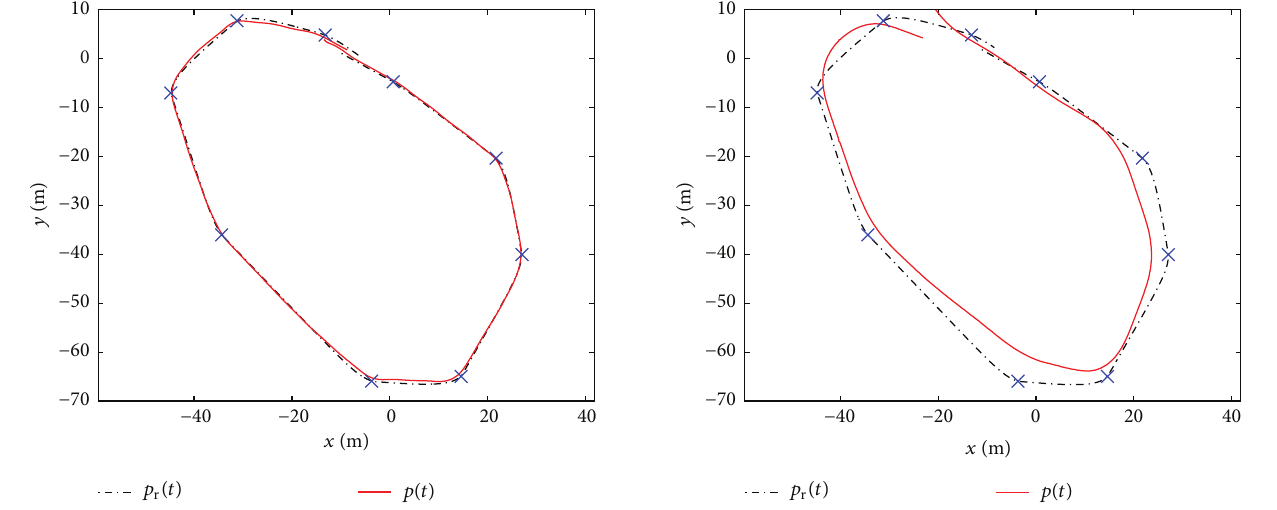
Figure 14: Tracking performance at 2m / s. The crosses are desired waypoints.